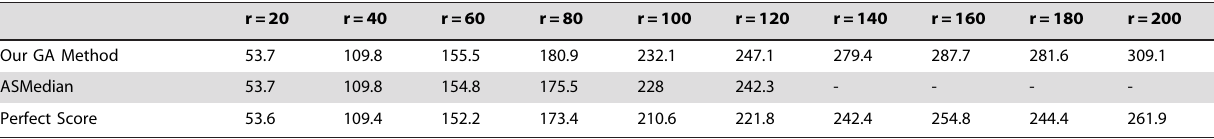
Comparison of the median scores (the lower the